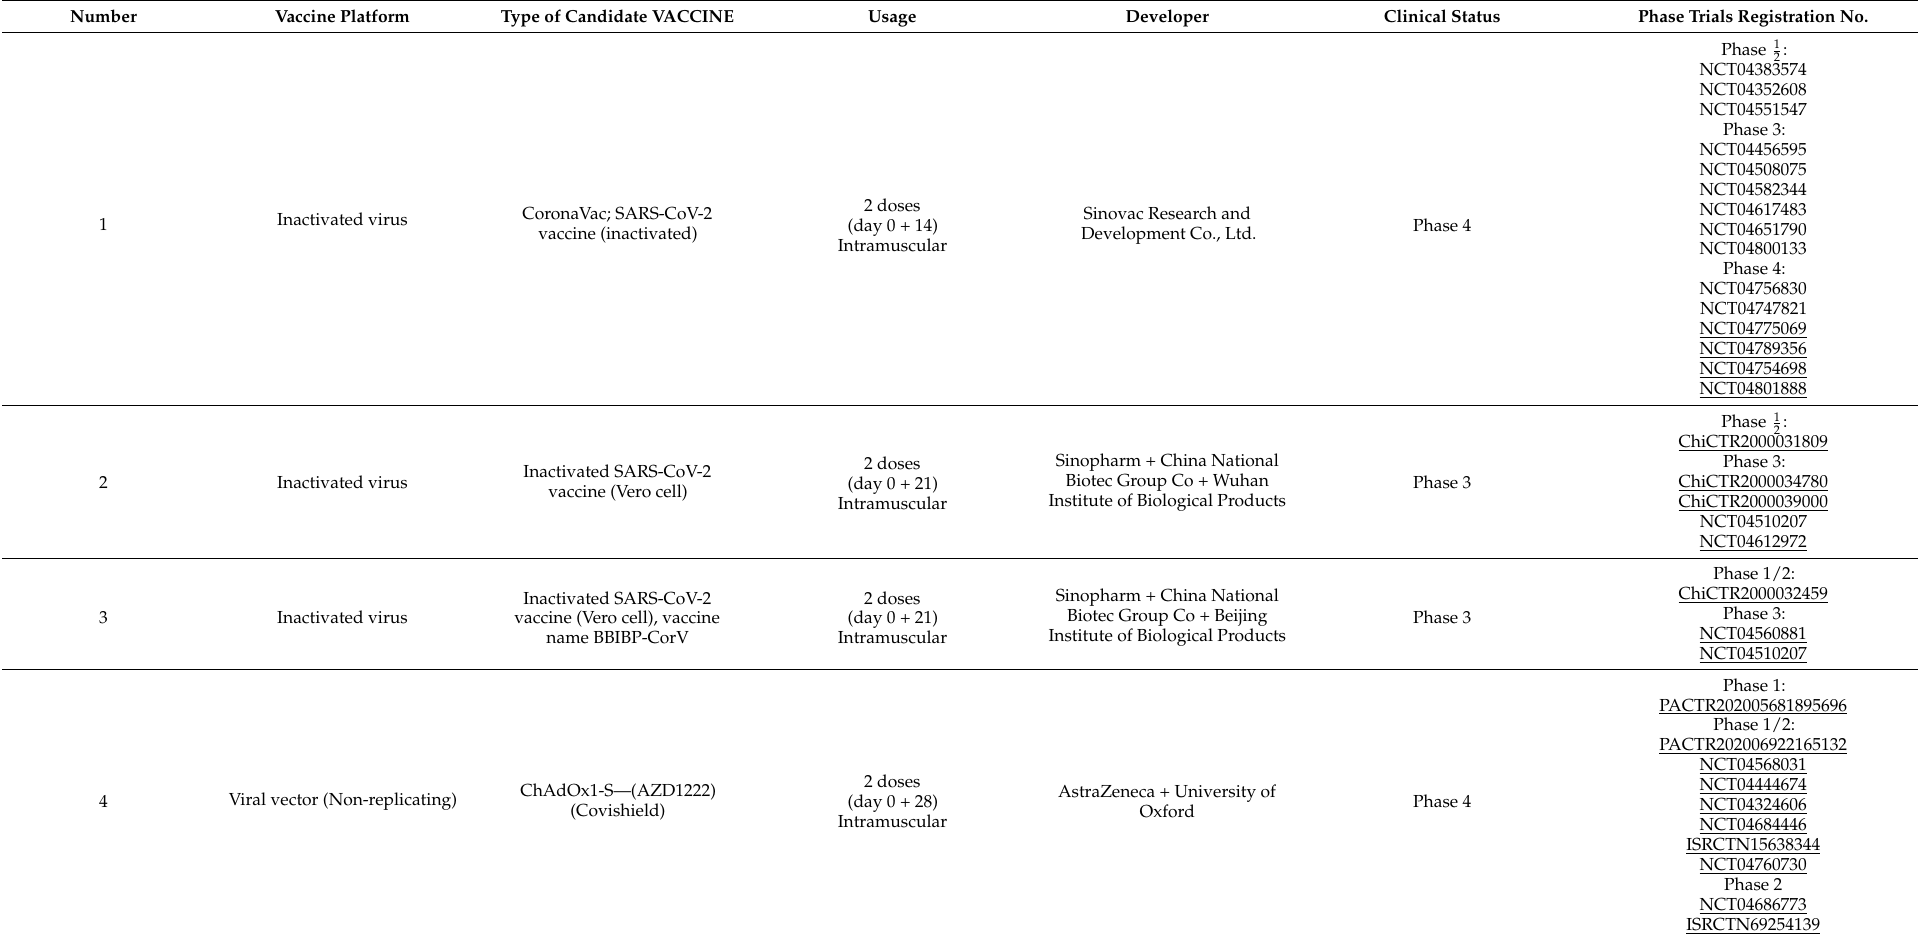
Table 3. Progress of existing 86 vaccines candidates in clinical trial as at 6th April